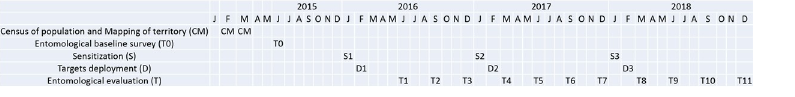
Fig 2. Timeline of activities undertaken in the intervention area between February 2015 and December